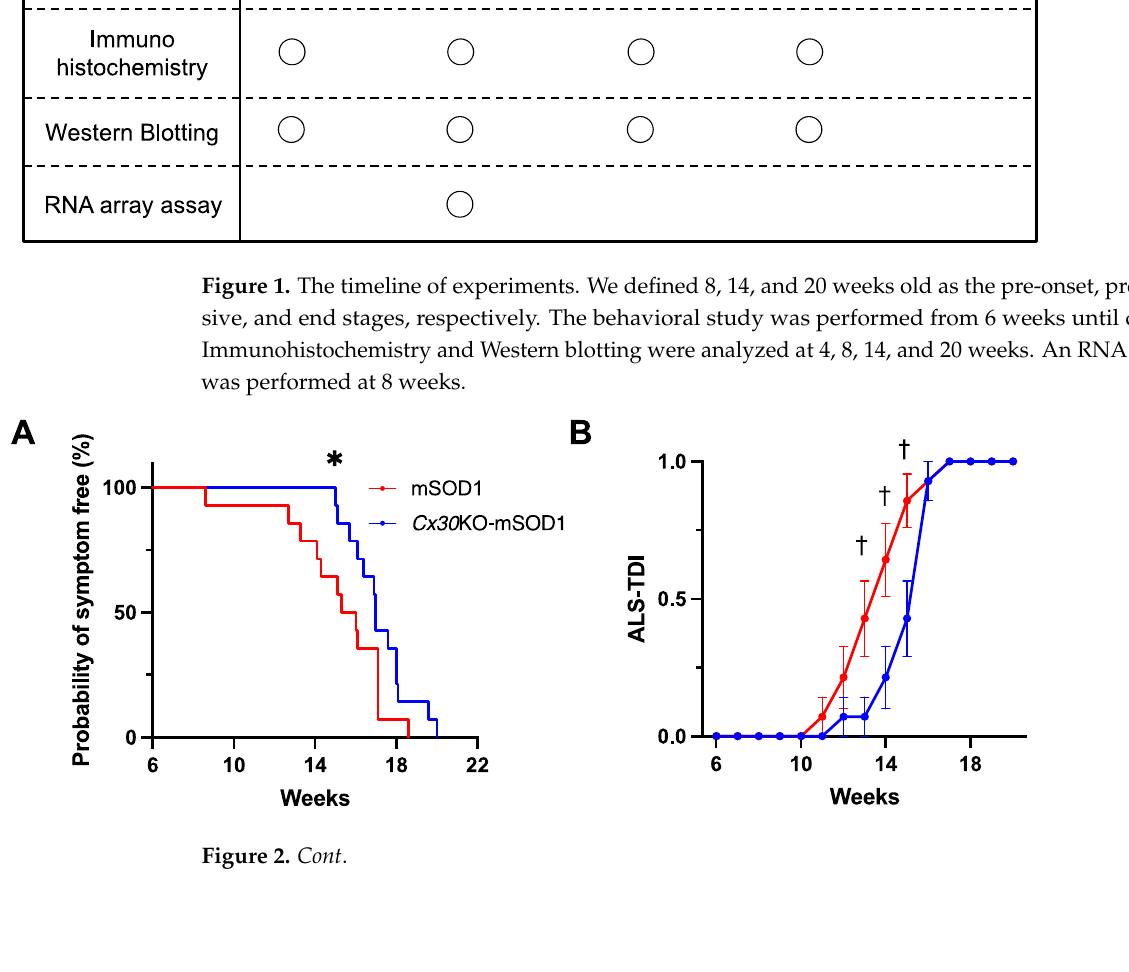
Figure 2. Phenotypic features of Cx30 KO-mSOD1 mice and mSOD1 mice. ( A ) Symptom-free sur- vival curve, ( B ) ALS-TDI score, ( C ) grip strength, ( D ) rotarod test, ( E ) curve of the decline in rotarod test performance, and ( F ) survival curve ( Cx30 KO-mSOD1 mice and mSOD1 mice, n = 14). Red and blue lines indicate mSOD1 and Cx30 KO-mSOD1 mice, respectively. Means and SEM are shown. The Gehan − Breslow − Wilcoxon test was used to statistically compare the timing of onset as the timing of body weight peak. Multiple t-tests were used to statistically compare ALS-TDI scores, grip strength data, and rotarod test data. The log-rank test was used to compare declines in rotarod test perfor- mance and survival time ( p = 0.22 and 0.09, respectively). * p < 0.05 and † p < 0.001. 2.2. Cx30 Deficiency Decelerates Cell Loss in the Lumbar Spinal Cord of SOD1 G93A ALS Mice We compared numbers and sizes of lumbar spinal cord neurons at 8 weeks (pre-onset stage), 14 weeks (progressive stage), and 20 weeks (end stage). Immunohistochemistry with an anti-NeuN antibody showed that anterior horn cells gradually decreased over the disease course in mSOD1 and Cx30 KO-mSOD1 mice (Figure 3A–C). Furthermore, dorsal horn cells were reduced and cells were smaller in mSOD1 and Cx30 KO-mSOD1 mice at